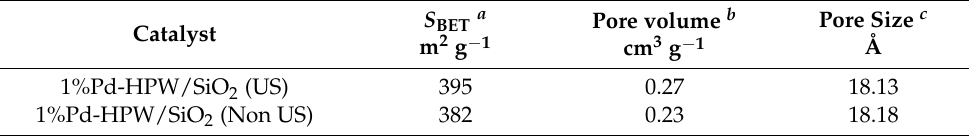
Table 1. The texture and Pd dispersion of the catalysts studied.